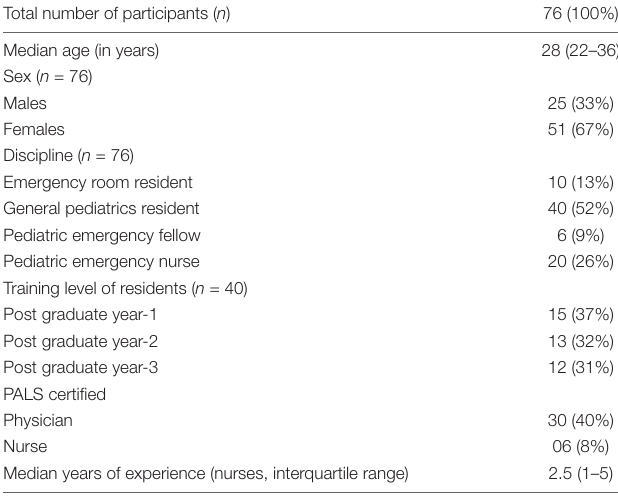
TABLE 2 | Baseline real patient